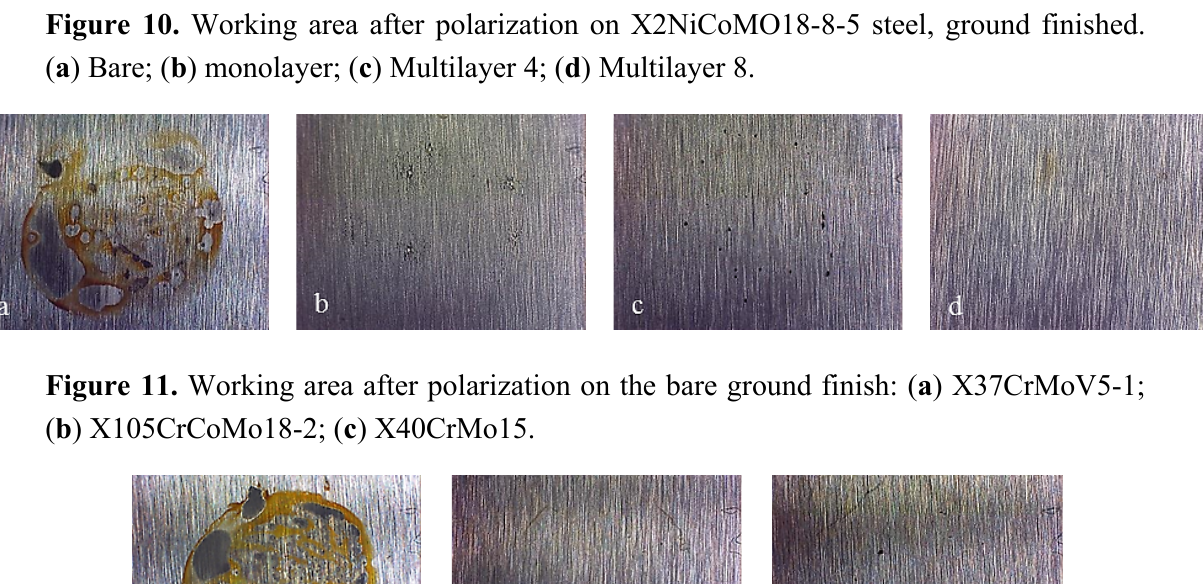
Figure 10. Working area after polarization on X2NiCoMO18-8-5 steel, ground finished.